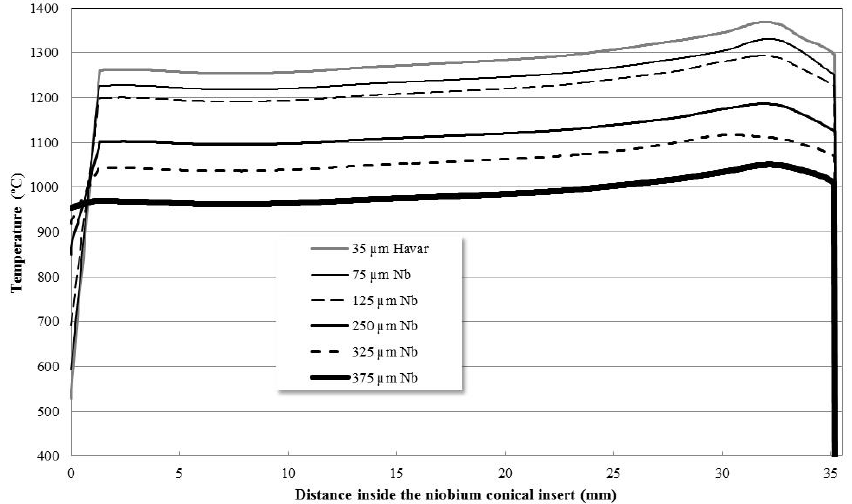
Figure 22. Temperature of the liquid target at the axis of the cavity, along the beam patch, for the different target windows considered.